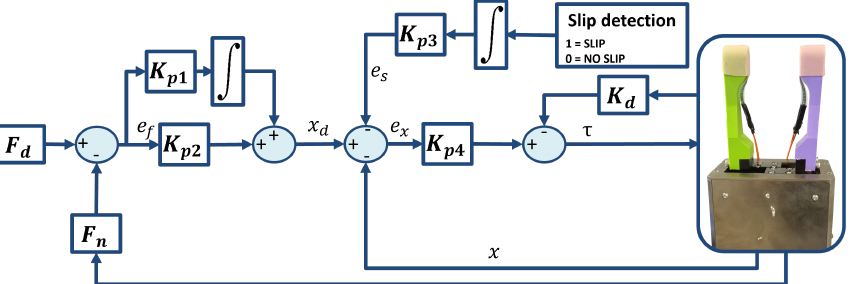
Figure 2. Force-and-slippage control